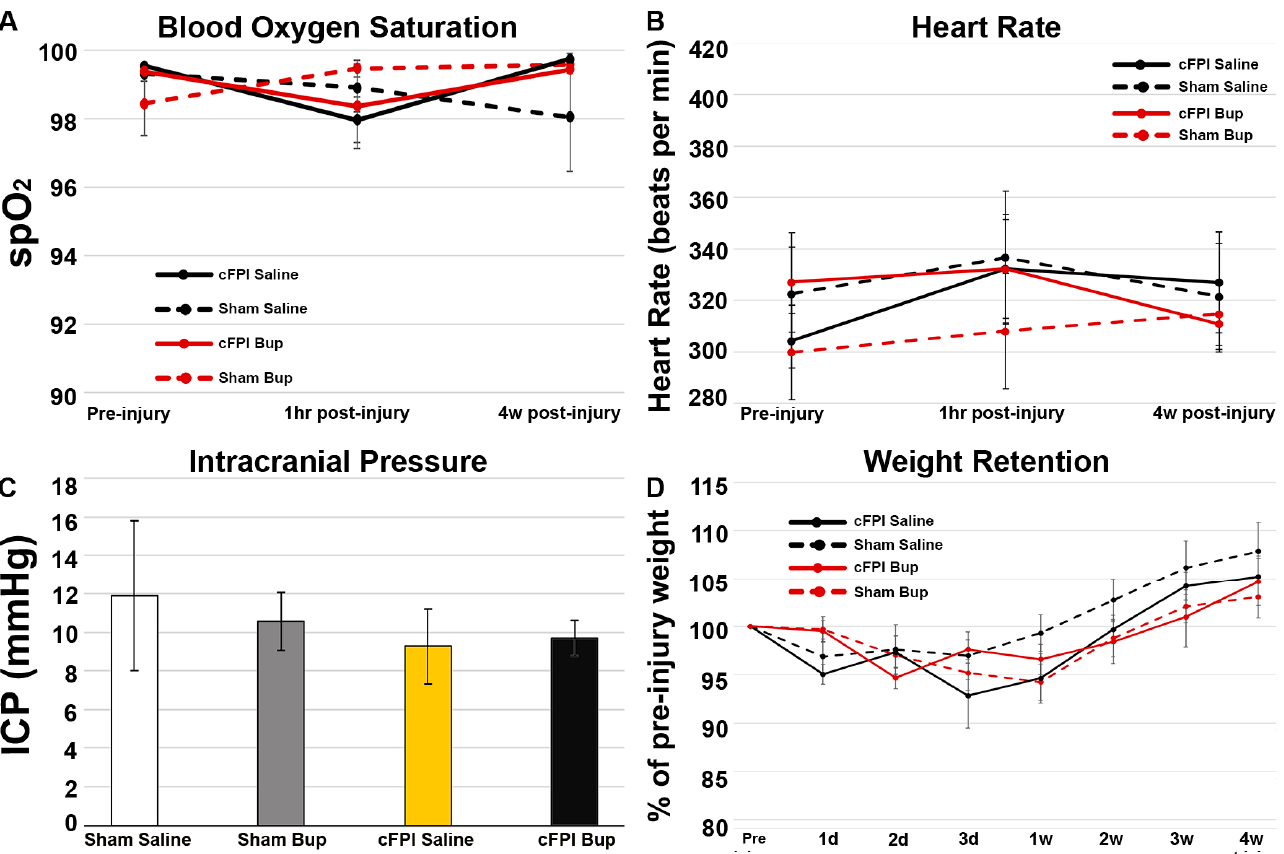
Figure 1. No significant changes in physiology or weight retention with Bup-SR-Lab (Bup) treatment following central fluid percussion injury (cFPI). Physiological readouts of ( A ) blood oxygen saturation and ( B ) heart rate in saline and Bup treated adult male rats pre-injury, 1 h, and 4w post-cFPI or sham injury. ( C ) Bar graph representing the average Intercranial pressure (ICP) of animals at 4w post sham or cFPI. ( D ) weight retention from pre-injury weight (100%) over the 4w time course. Animals in all groups lost weight following either sham or cFPI but were above their pre-injury weight by 4w post-injury and there were not differences between groups. n = 6 rats/group. Mean ±